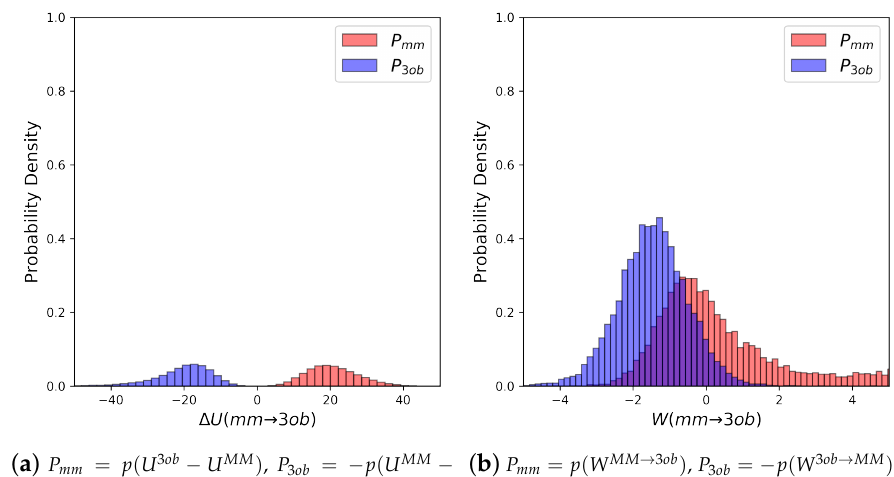
Figure 4. ( a ) Molecule 11 ’s potential energy “forward” ( P mm ) and “backward” ( P 3 ob ) distributions plotted as “offset” from the ∆ U MM → 3 ob to simplify the x-axis. ( b ) Molecule 11 ’s nonequilibrium work “forward” ( P mm ) and “backward” ( P 3 ob ) distributions plotted as “offset” from the W MM → 3 ob to simplify the